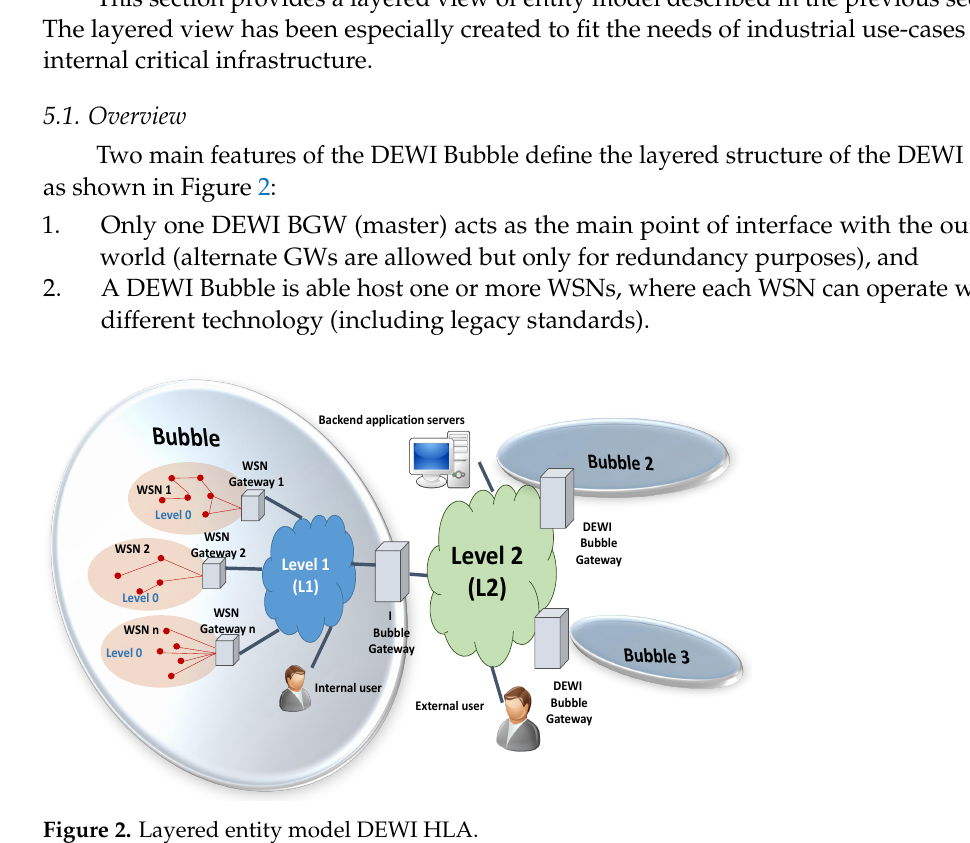
Figure 2. Layered entity model DEWI